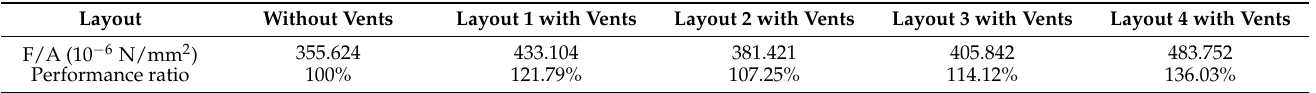
Table 3. Performance improvement with exhaust vents (quad-vortex grippers, configuration